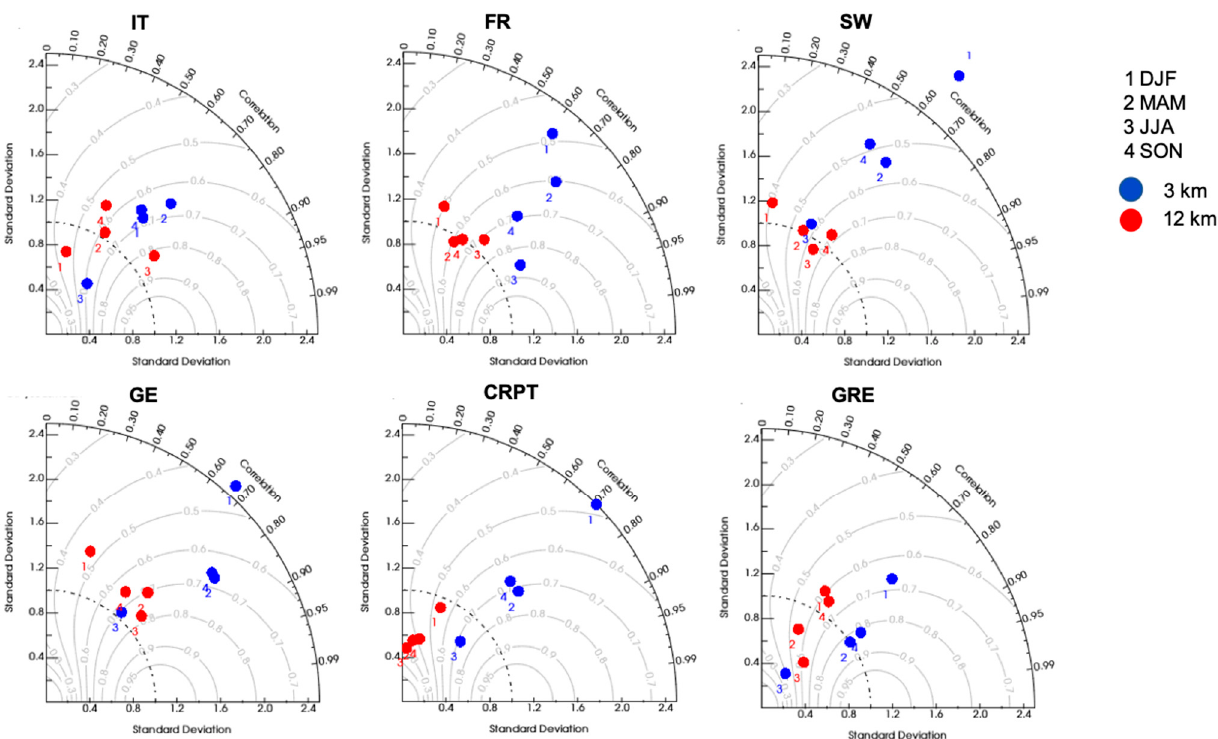
Figure 8. Spatial Taylor diagrams exploring model performance in terms of the spatial variability of mean seasonal daily precipitation over six regions—Italy (IT), France (FR), Switzerland (SW), Germany (GE), the Carpathians (CRPT), and Greece (GRE). The diagrams combine the spatial correlation (cos; azimuth angle) and the ratio of spatial variability (radius). The grey isolines show an additional measure of skill [97], with the skill score defined to vary from zero (least skilful) to one (most skilful). Red circles indicate results obtained by RegCM4-NH (12 km) simulation, while blue circles indicate results obtained by CP-RegCM4-NH (3 km) simulation.